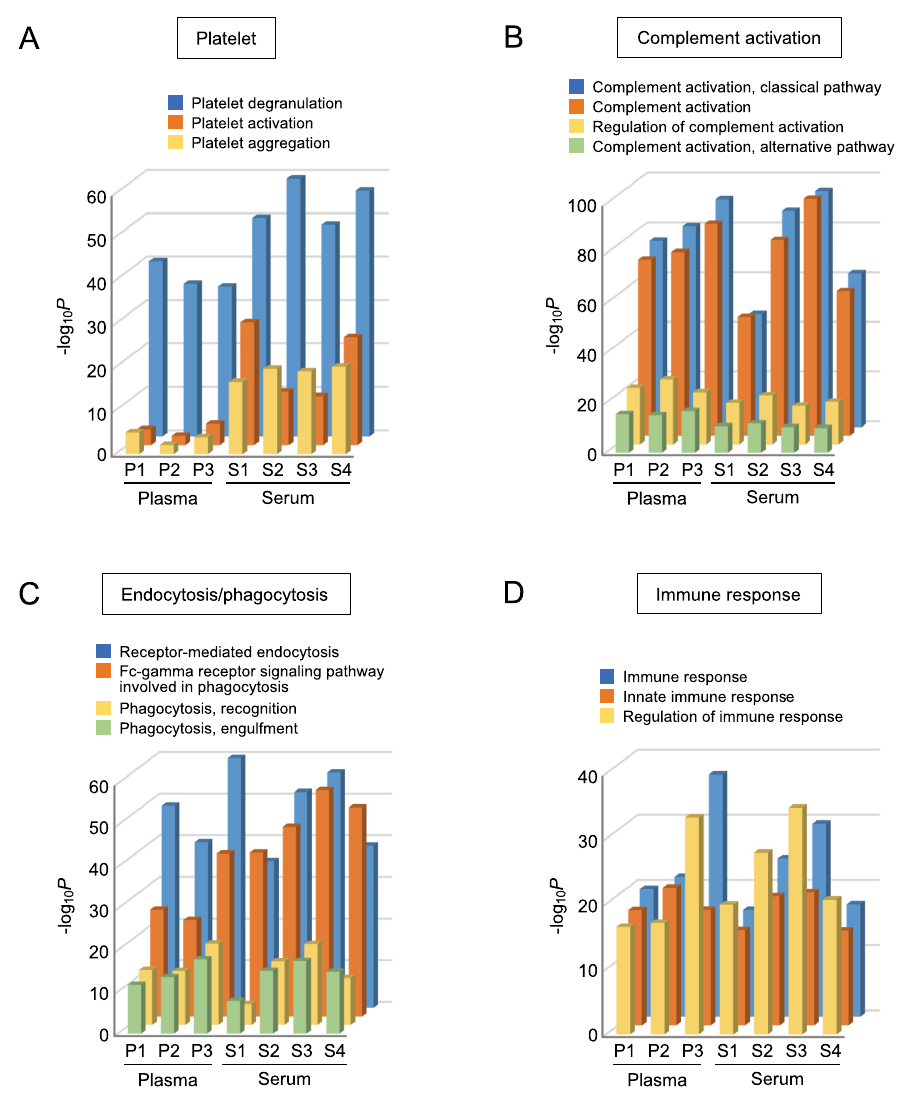
Fig 6. Platelet-associated proteins are generally enriched in serum EVs. (A-D) Bar graphs showing modified Fisher’s exact P -values of the GO biological process terms associated with platelets (A), complement activation (B), endocytosis/phagocytosis (C), and immune response (D), which were calculated from the proteomic data of plasma EVs (P1, Zheng et al.; P2, Yentrapalli et al.; P3, Bezdan et al.), and serum EVs (S1, Zhong et al.; S2, An et al.; S3, Ding et al.; S4, Luo et al.) reported from other groups. The GO terms associated with platelets were significantly enriched in serum EVs compared with plasma EVs, whereas the other GO terms showed almost comparable enrichment among the studies